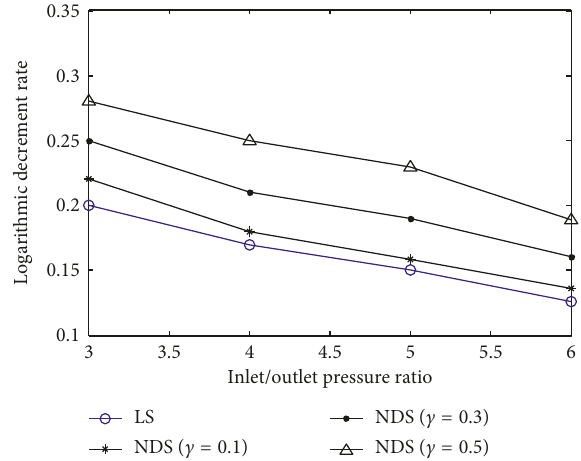
Figure 12: Influence of rotating speed on logarithmic decrement rate.